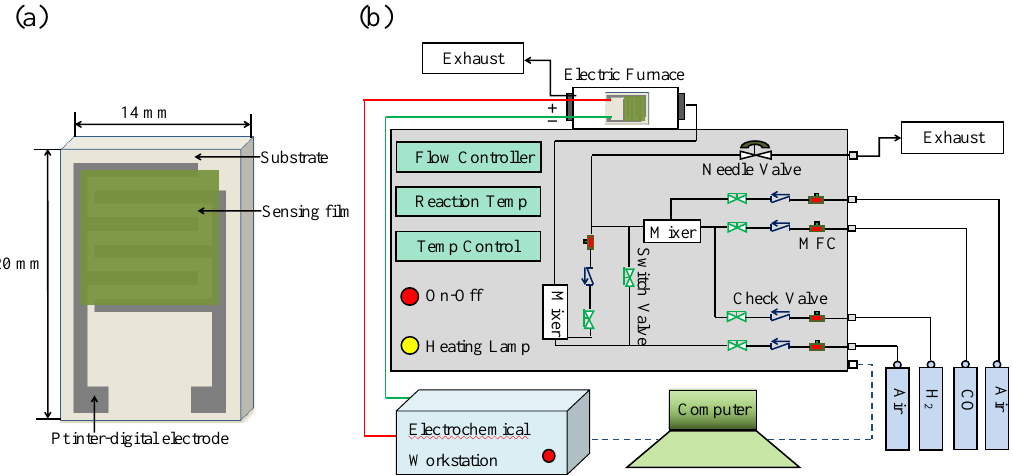
Figure 1. Schematic diagram of ( a ) the sensor component and ( b ) the gas sensing measurement system.